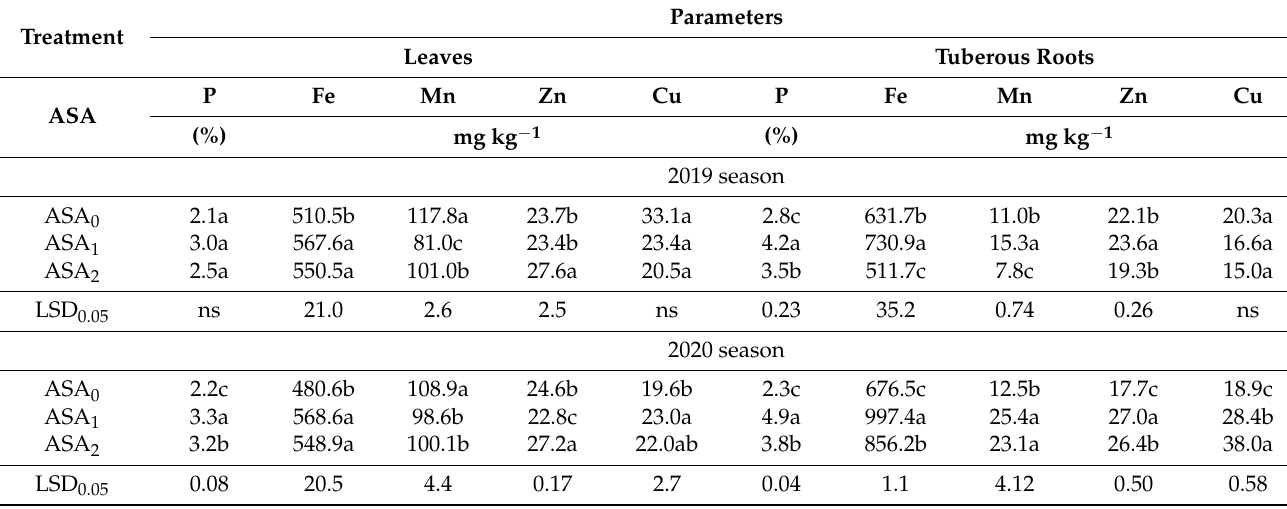
Means in the same column denoted by a different letter indicate significant difference between treatments at p ≤